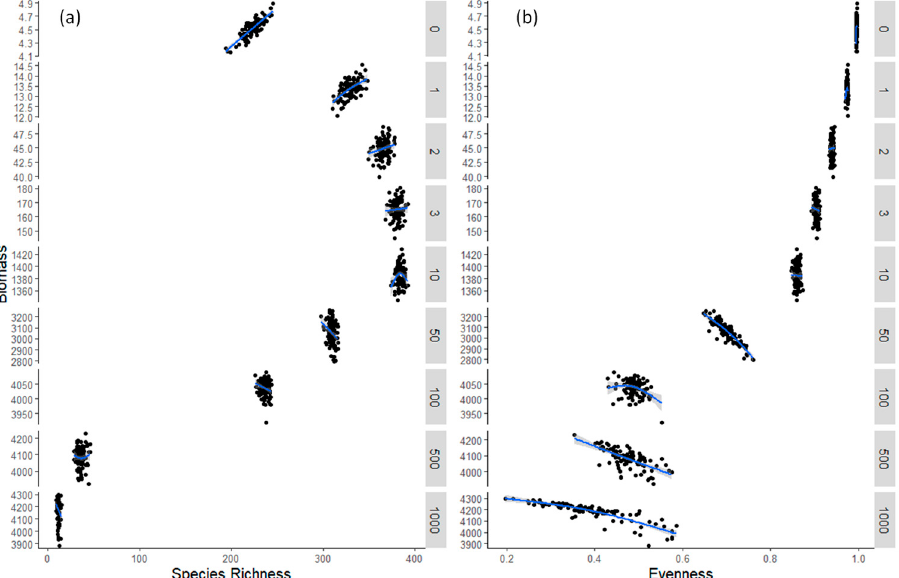
Figure 4. Model results between ( a ) species richness S and ( b ) evenness J (on x-axis) and biomass (y-axis) for different days (0–1000) during simulations. For each day, the 100 replicates are plotted. Table 1. Slopes and their statistical significance for the equations. ln(biomass) = aS + b and ln(biomass) = aJ + b.